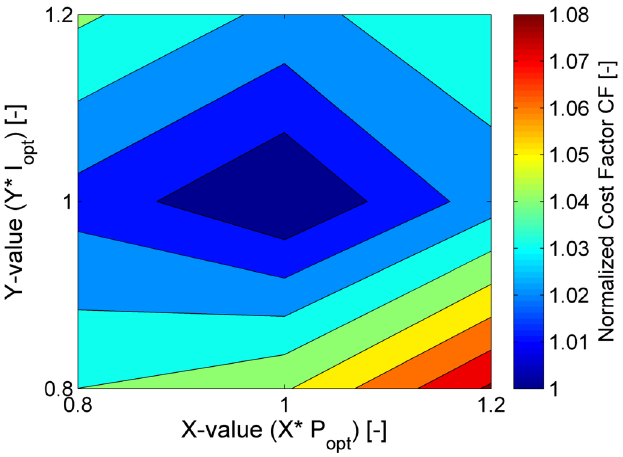
Figure 14. Comparison of Cost Factor CF using PI controller (Case 3) with different damping and stiffness coefficients. The CF values are normalised by the optimal P ( P and I ( I ) controller values where the power output is maximised. The value p is set equal opt to 10% and the Cross Section Area data refers to the Weld 1